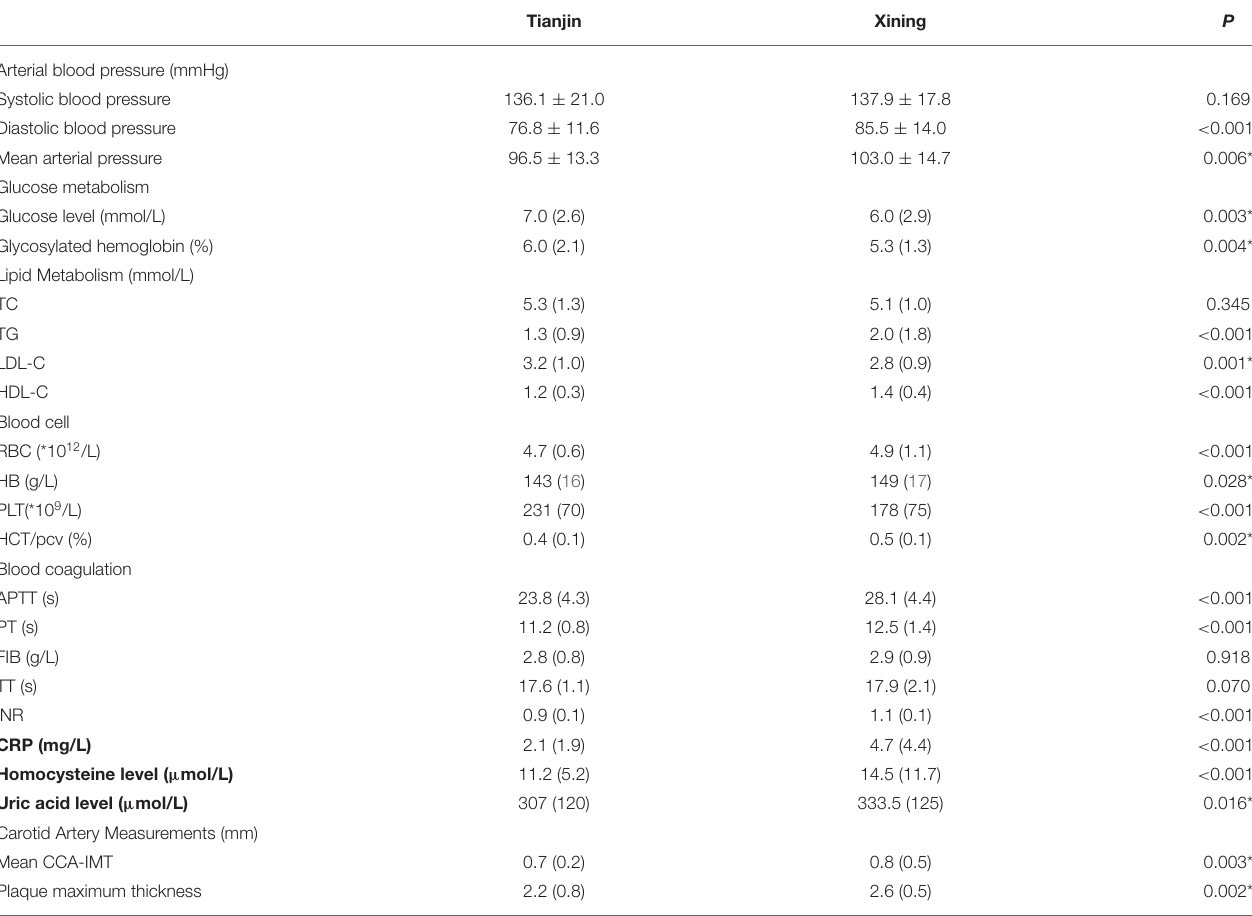
TABLE 3 | Laboratory results with acute ischemic stroke at different